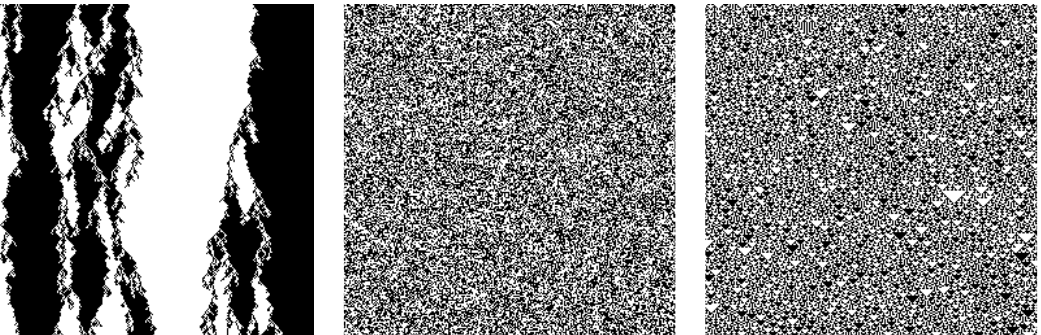
Figure 9. Typical space time patterns of the BBR model for p 2 = 1 increases downward: ( Left ) competition between quiescent phases p 1 = 0.1; ( Middle ) disordered phase p 1 = 0.5; and ( Right ) chaotic phase p 1 = 0.6. Figures from